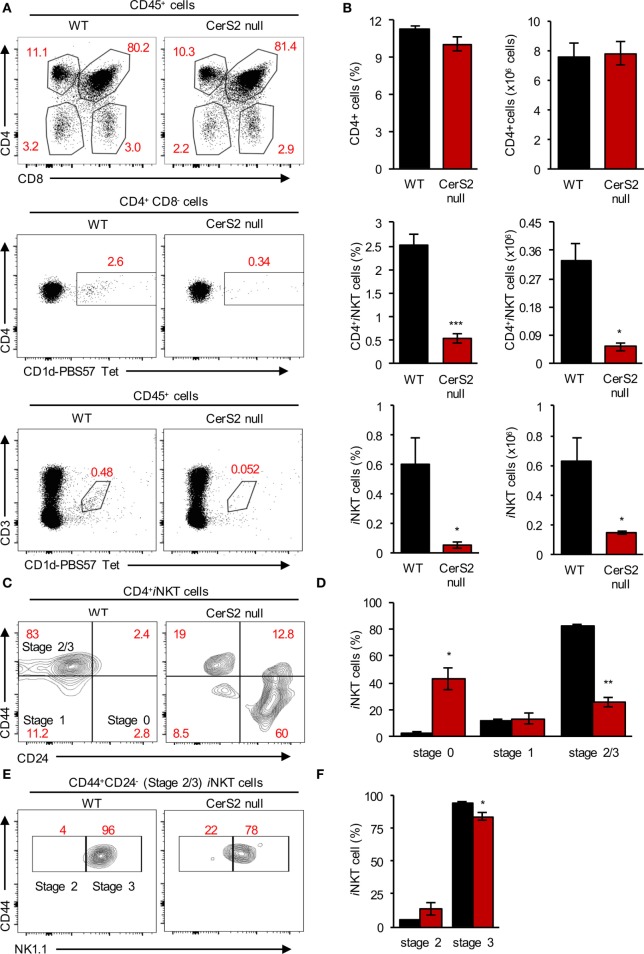
Reduced levels of invariant NKT (iNKT) cells in the thymus of ceramide synthase 2 (CerS2)-null mice is due to their impaired maturation in the thymus. (A) Representative flow cytometry plots showing the frequencies of thymocytes (upper panel), CD4+CD1d-PBS57 tetramer+
iNKT cells (middle panel), and CD3+CD1d-PBS57 tetramer+
iNKT cells (lower panel) out of total hematopoietic cells in wild-type (WT) and CerS2-null mice. (B) Average percent and absolute number of the indicated cells (n = 5). (C,E) Representative flow cytometry contour plots showing the percent of different developmental stages of iNKT cells in the thymus. (D,F) Average percent of iNKT cells at different developmental stages in the thymus (n = 3). The experiment was repeated two times with similar results. Percents are indicated in red. Black columns, WT; red columns, CerS2 null.